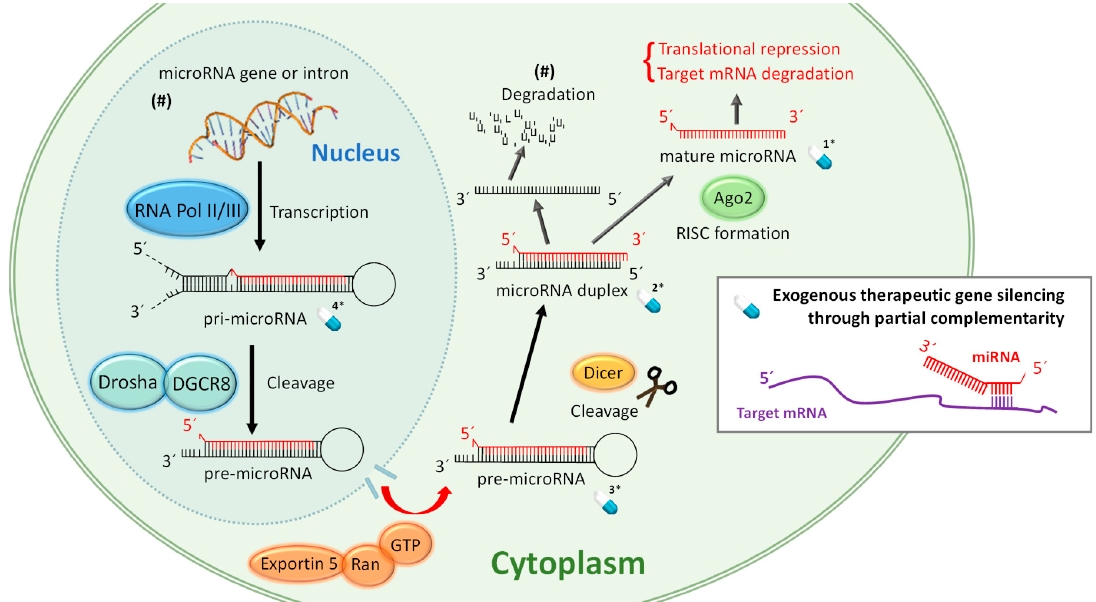
Figure 1. One of the possible mechanisms and pathways of the miRNA biogenesis within eukaryotic cells of mammals. We have marked with a blue pill drawing and a number 1* to 4* the possible miRNA and miRNA precursors that can be targeted for the different therapeutic strategies explained in section 4. (#) Indicates that this pathway can be different.